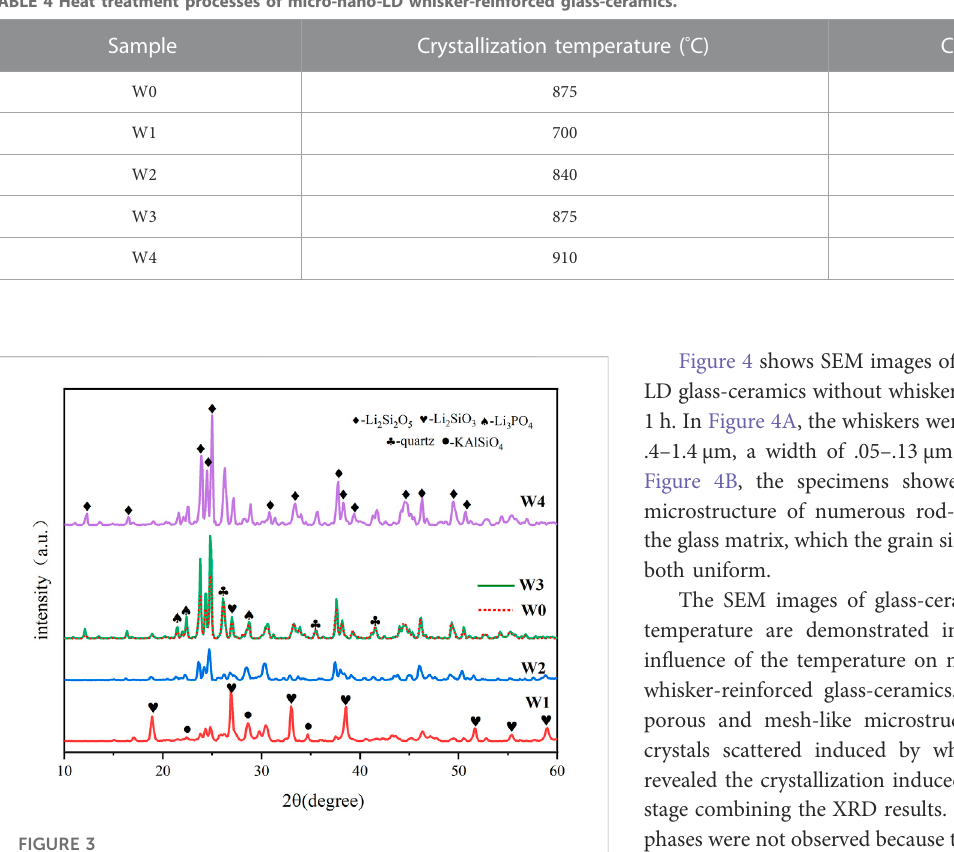
FIGURE 3 X-ray diffraction patterns of LD glass-ceramic samples treated by different